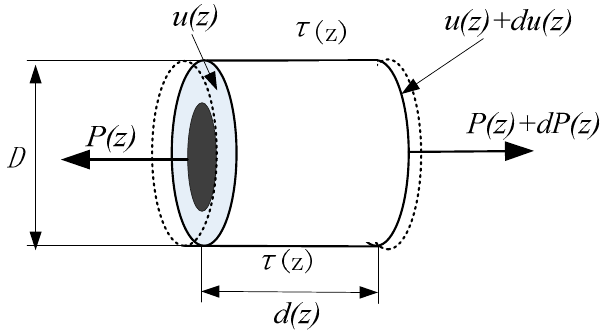
Figure 6. Stress analysis of bolt-coating body.